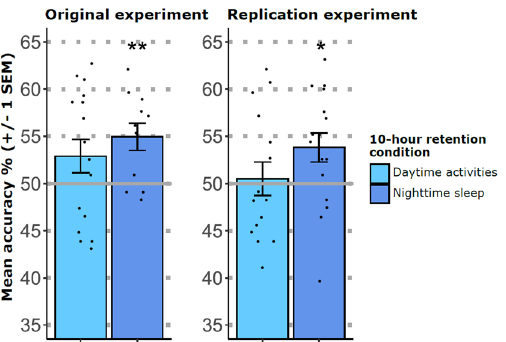
Figure 4. Retrieval accuracy in the 10-h retention condition following strong masking. In the original experiment with strong masking, the high-working-memory performers yielded an above-chance retrieval accuracy, if the 10-h retention interval was filled with night sleep. Also in the replication experiment with strong masking, the high-working-memory performers yielded an above-chance retrieval accuracy, if the 10-h retention interval was filled with night sleep. Asterisks represent significant one-sample t-tests against chance- level ( α = .025; * p < 0.025, BF 10 = 9.2; ** p < .01, BF 10 = 114.28; one-tailed). Error bars represent the standard error of the mean